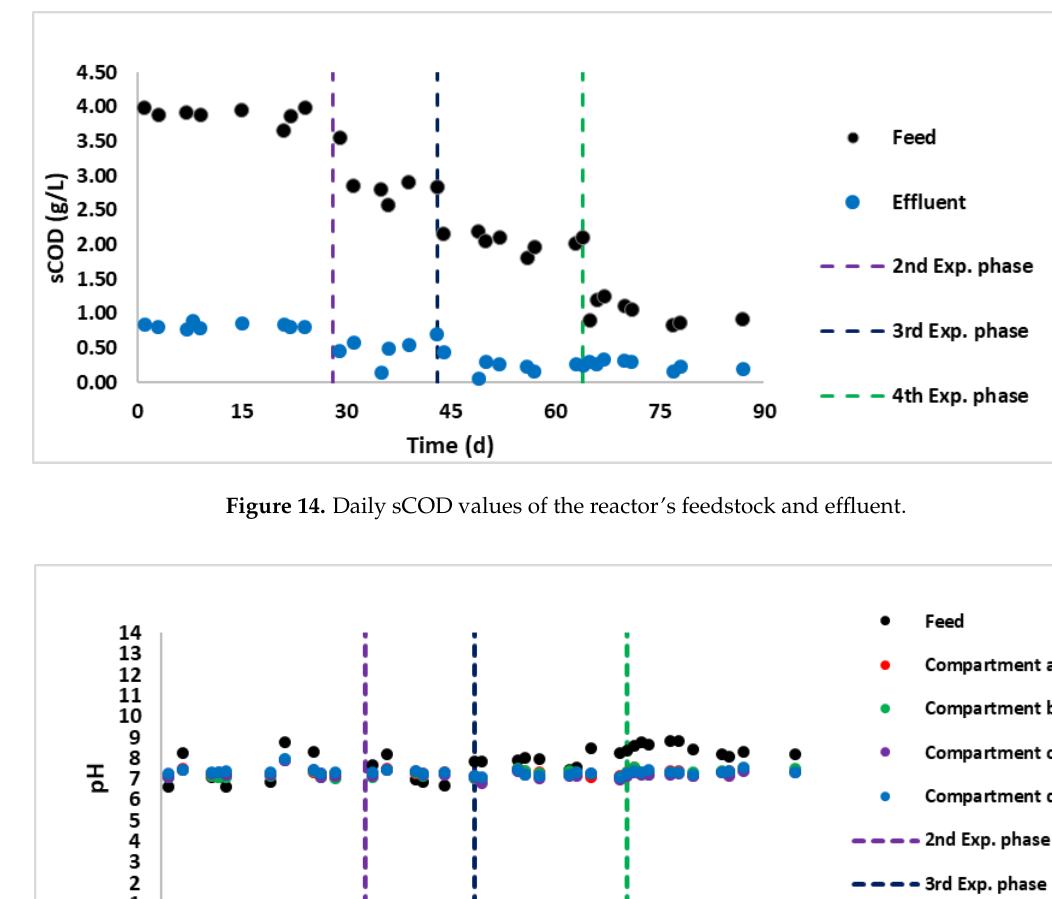
Figure 14 . Daily sCOD values of the reactor ’ s feedstock and effluent.